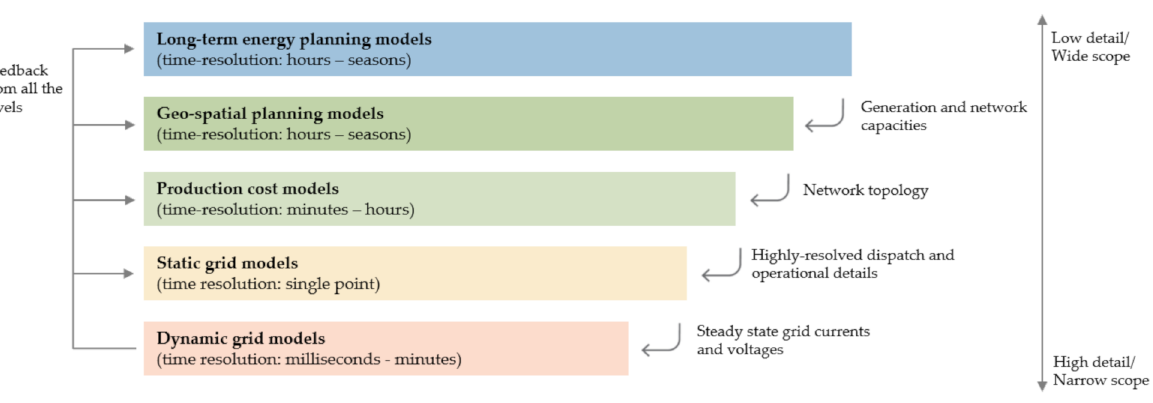
Figure 3. Tools with different scopes and their feedback loops for energy system scenario planning